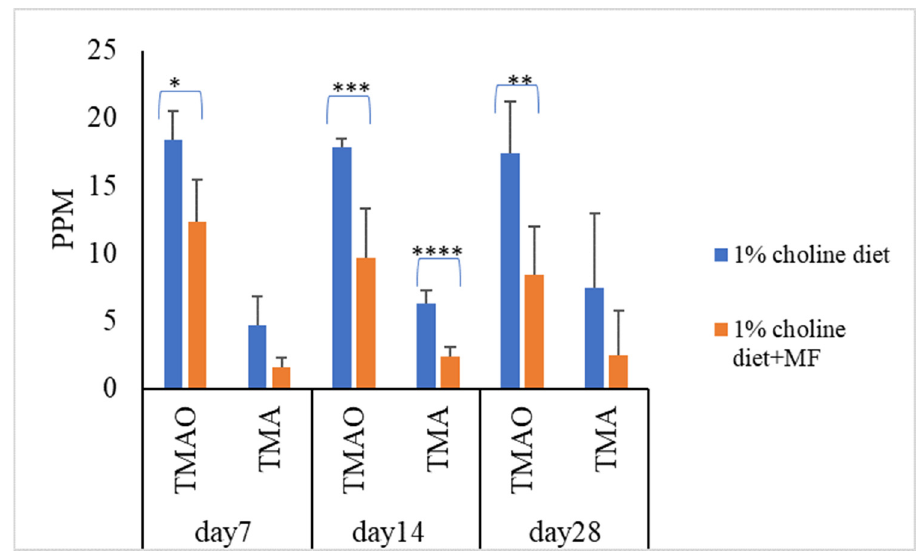
Figure 1. Probiotic multistrain formula decreases the plasma TMAO and TMA levels in C57BL/6J mice. Experimental conditions were as described in Methods. Data are shown as mean values ± SD ( n = 7). A p -value of <0.05 was considered to be statistically significant, * p <0.05, ** p < 0.01, *** p <0.001, **** p < 0.0001.